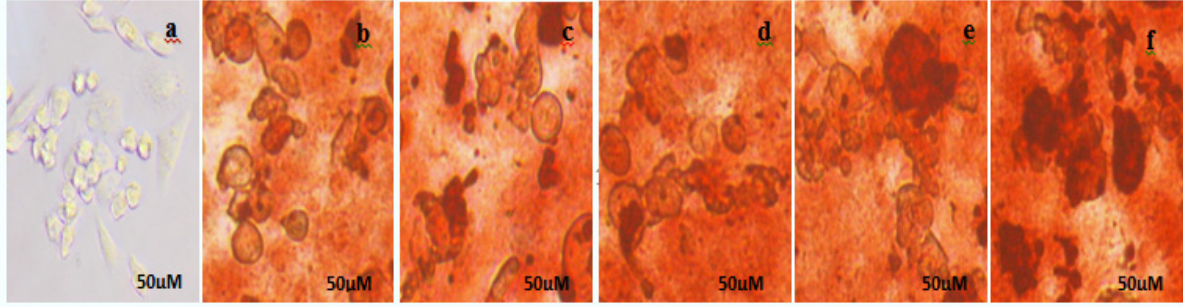
Figure 9: :Alizarin Red stain of the study group on day 21 under microscope with a magnification of X200.Alizarin red stain deeply stains calcium nodules formed after osteogenic differentiation where a: for control group , b :for vitamin D only group, c: for group 1J/cm 2 , d :for 1J/ cm 2 + vitamin D, e :for 2J/cm 2 group, f: group of vitamin D and 2j/cm 2